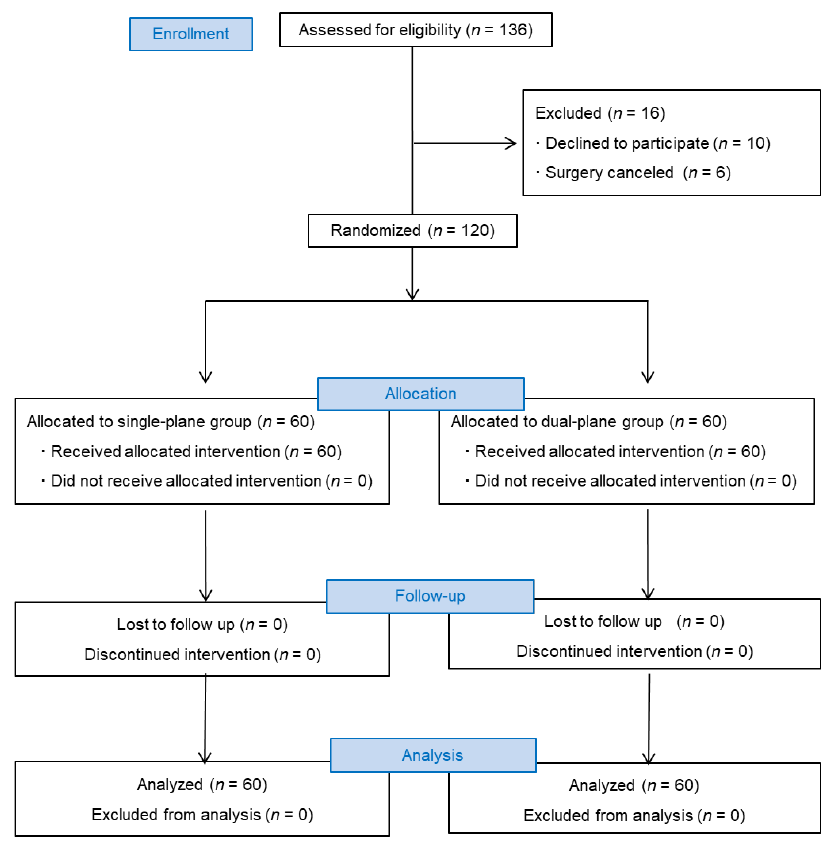
Figure 1. CONSORT study design. CONSORT, Consolidated Standards of Reporting Trials.